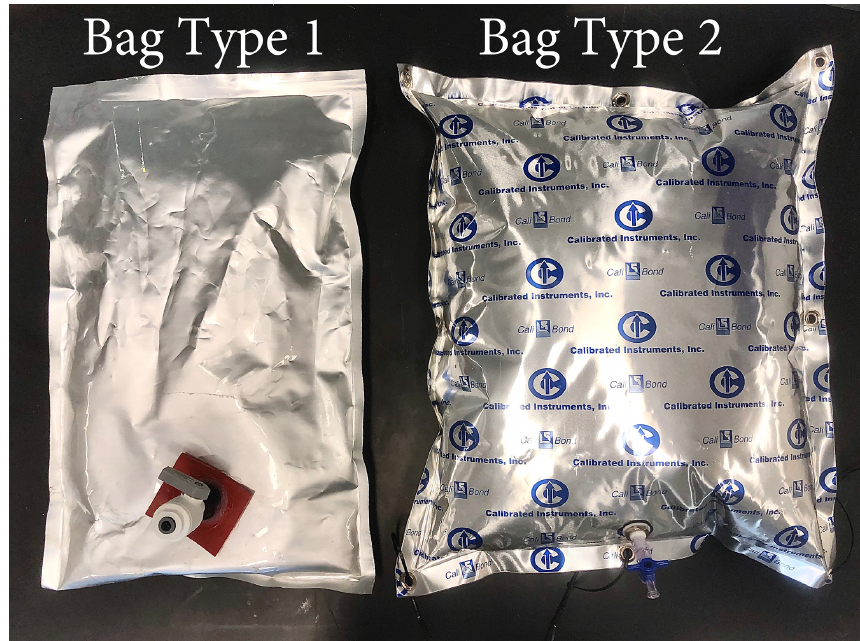
Figure 1. A picture of bag type 1 and 2 used to store tris in this